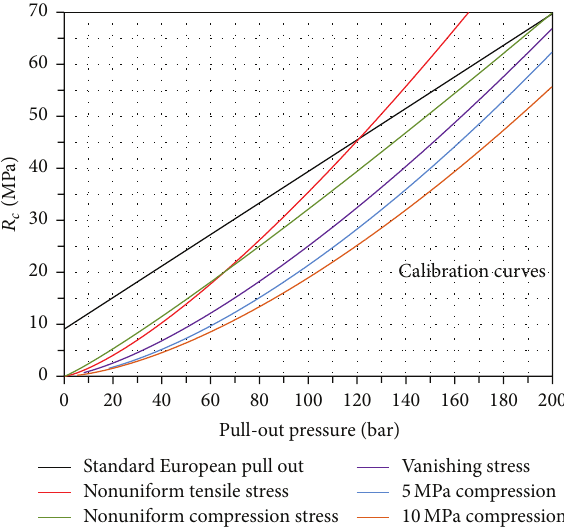
Figure 16: Calibration curve for nonuniform compression stress.